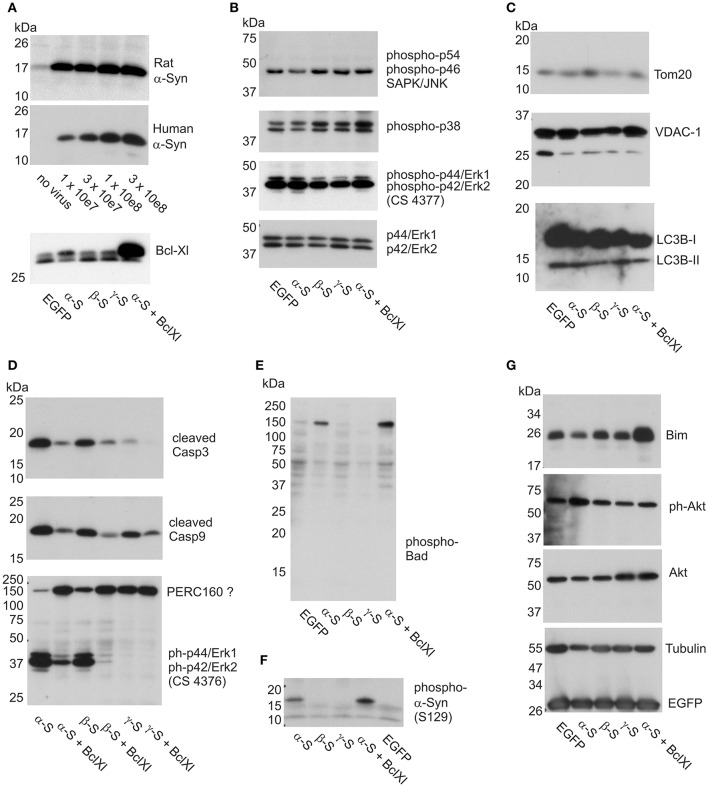
Impact of α-Syn overexpression on stress kinases, caspases, and apoptosis-related proteins. Western blots are shown for cell lysates isolated from cortical neurons at 12 days of synuclein overexpression under denaturing conditions and electrophoresed on SDS-PAGE. (A) Expression analysis of AAV-expressed rat and human α-Syn at different AAV titres and Bcl-Xl (at 3x10e7 tu) to delineate the level of overexpression (see Materials and Methods for more details). (B) Detection of levels of phosphorylated JNK (panel 1), phosphorylated p38 (panel 2) and phosphorylated Erk (panel 3; antibody CS4377) stress kinases, detection of non-phosphorylated Erk is shown in panel 4 as loading control. (C) Detection of the levels of mitochondrial proteins Tom-20 (panel 1) and VDAC-1 (panel 2), and lysosomal proteins LC3B1 and −2 (panel 3). (D) Detection of levels of cleaved caspase 3 (panel 1), cleaved caspase 9 (panel 2), and phospho-Erk (panel 3; antibody CS4376). (E) Detection of phospho-Bad in a high molecular weight complex. (F) Detection of phosphorylated α-Syn (S129). (G) Detection of Bim and Akt, Tubulin and EGFP (which is co-expressed with the synucleins) as loading controls. EGFP, neurons transduced with AAV-EGFP (1 × 10e8 tu); α-S, neurons transduced with AAV-α-Syn-EGFP (expressing α-Syn and EGFP from independent transcription units, 1 × 10e8 tu). ßS, neurons transduced with AAV-ß-Syn-EGFP (1 × 10e8 tu); γ-S, neurons transduced with AAV-γ-Syn-EGFP(1 × 10e8 tu); Bcl-Xl, neurons transduced additionally with AAV-Bcl-Xl (3 × 10e7 tu).